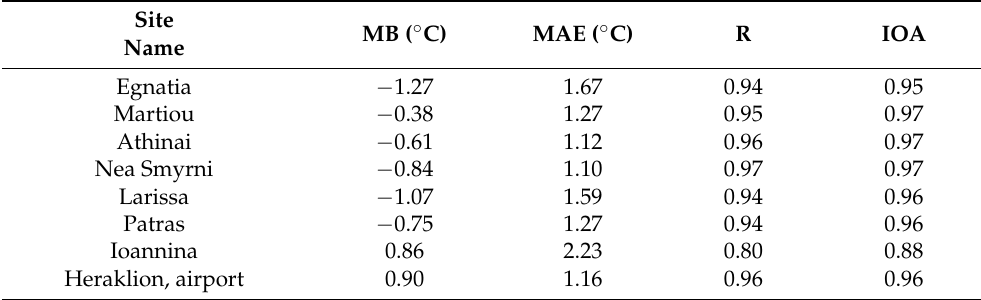
Table 1. Statistical metrics for the near-surface air temperature for each monitoring site over the cold period of 2015 (January–April,